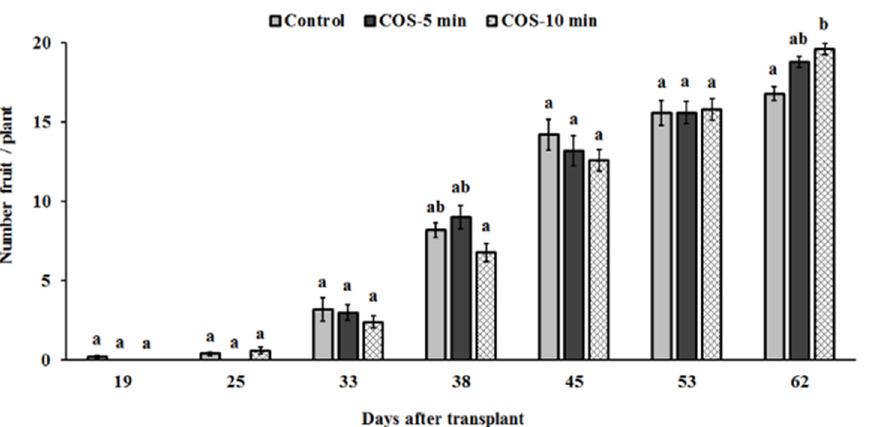
Figure 5. The effect of the EBP-produced COS on fruit number in tomato plants (cv. Micro-Tom). Treatments were applied three times after transplanting by foliar spray at 0.25 mg/mL (1, 25, and 37 days, respectively). Means ± SE followed by different small letter within the same time point indicate significant differences between treatments based on Fisher’s LSD test ( p ≤ 0.05). The labeling principle of columns ( a or b ) is the same as in Figure 4.